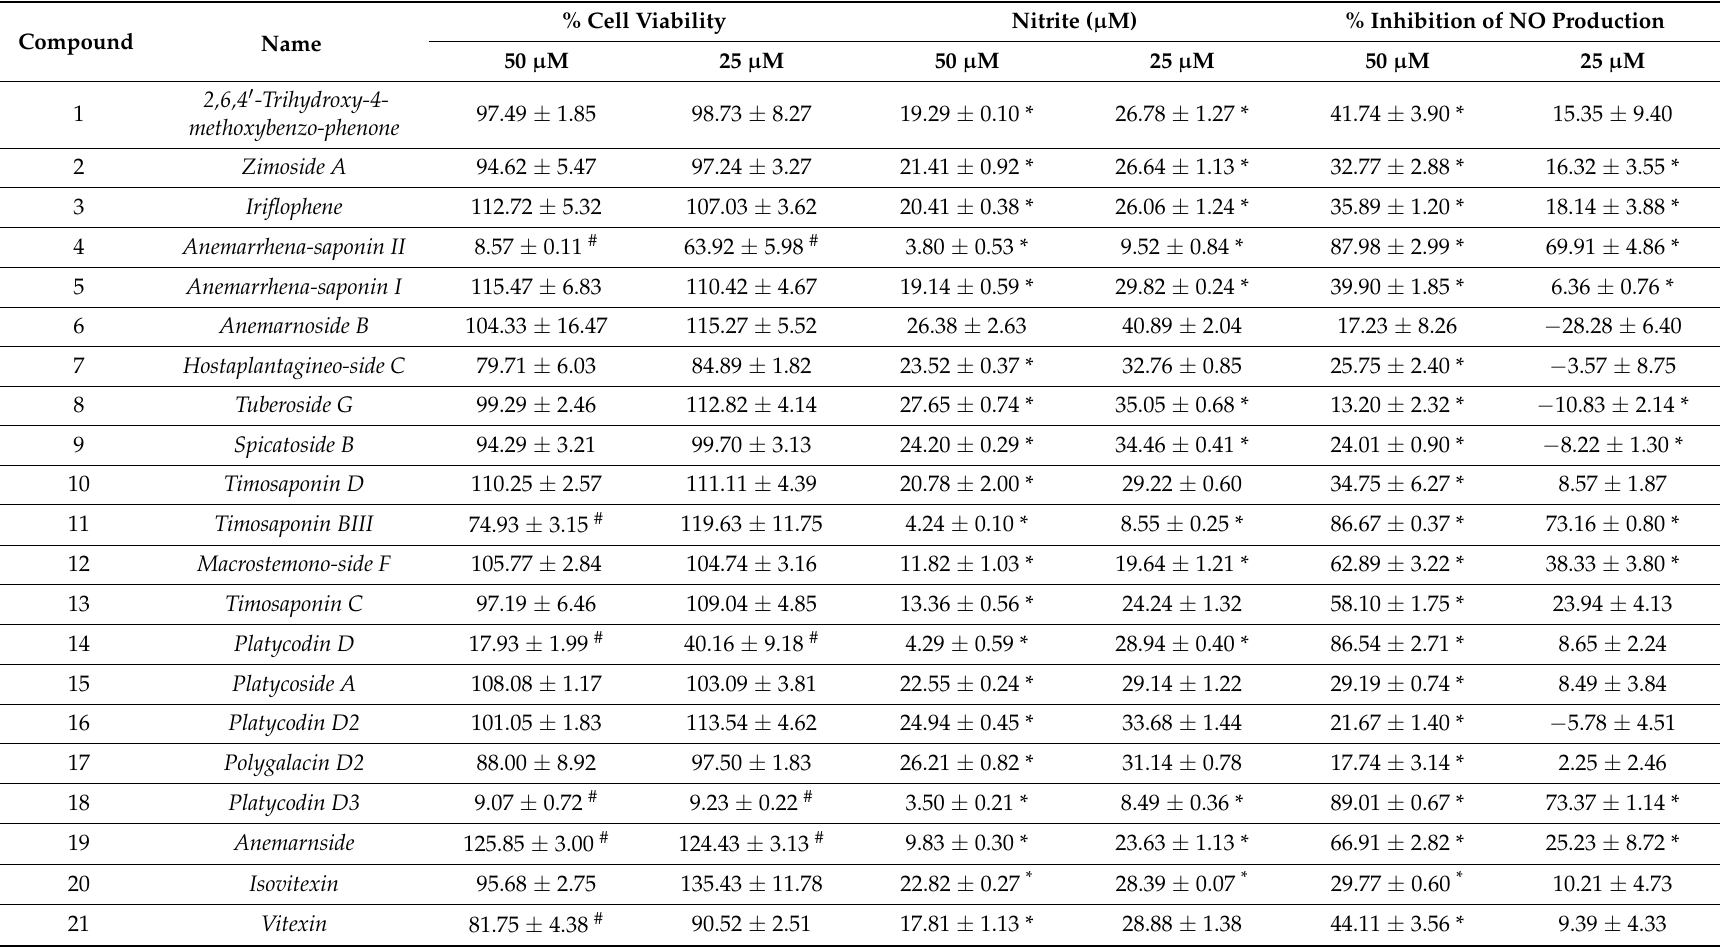
Table 1. Effects of isolated compounds on cell viability and NO